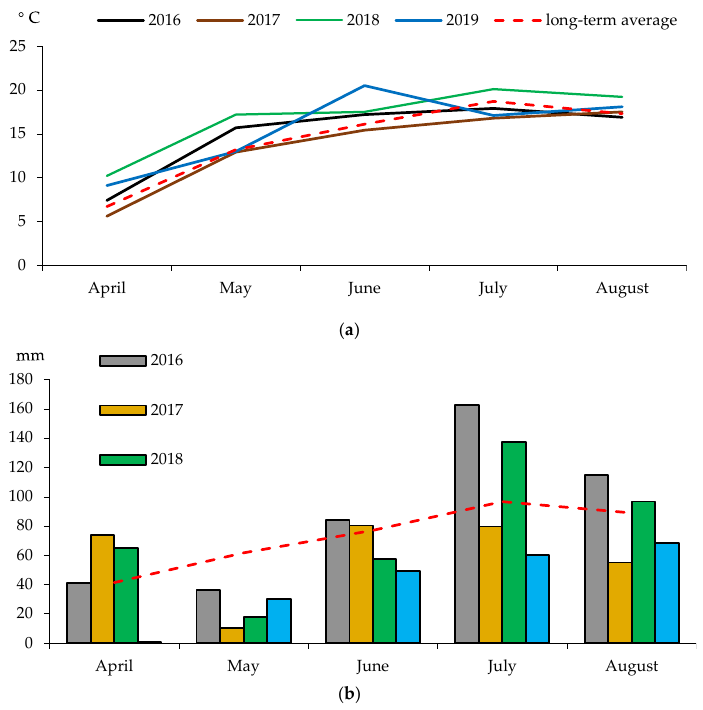
Figure 1. Average air temperature ( a ) and precipitation rate ( b ) during faba bean growing seasons. Kaunas Meteorological Station, 2016–2019.